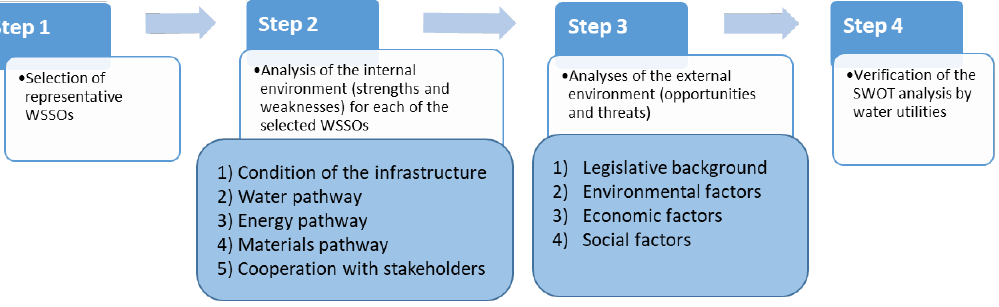
Figure 1. Methodology of the study.